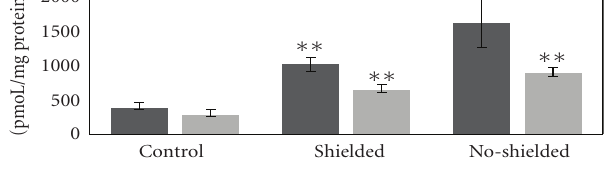
Figure 1: DNA ladder in control and shielded and no-shielded FTRL-5 cells cultured in the presence of TSH (TSH+) or after TSH starvation (TSH − ). St = standard; C+ = positive control obtained in TSH+ cells treated with UV-C radiations (254nm, 20 J/m 2 radiation fluence rate from a low-pressure mercury lamp for two seconds); C = control; S = shielded; NS = no shielded.